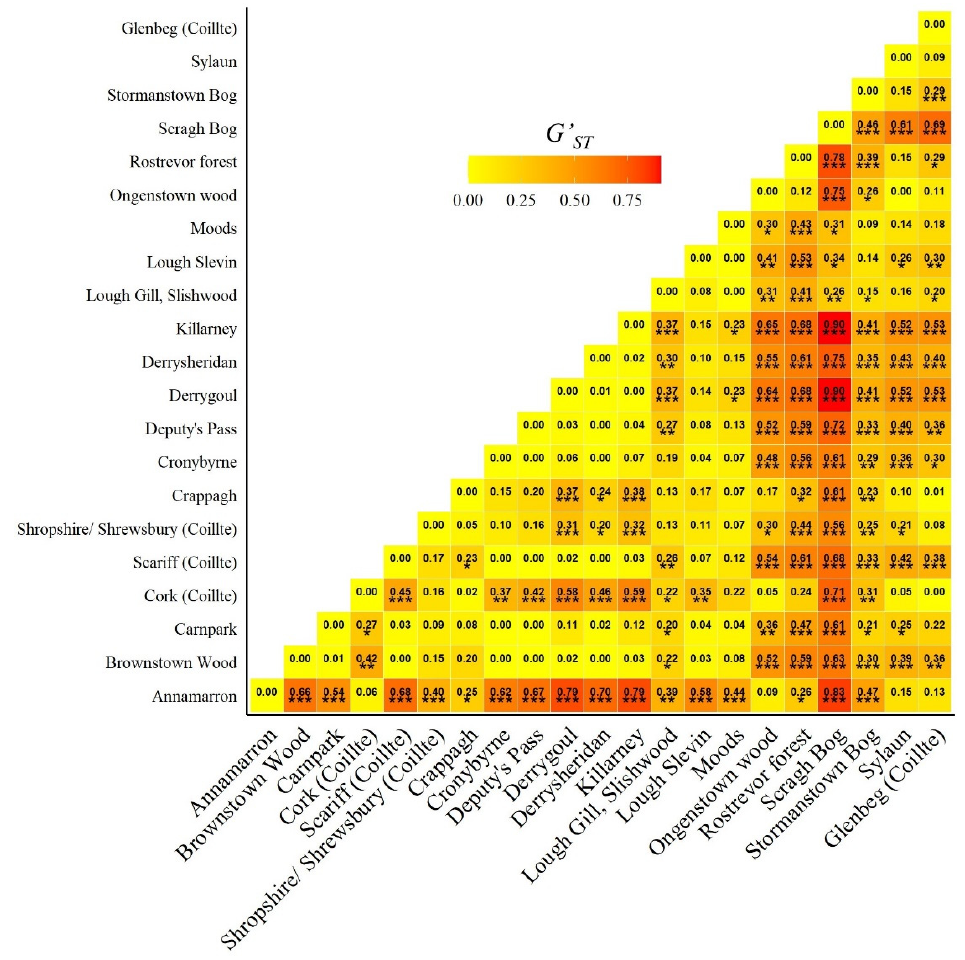
Figure 6. Pairwise G’ ST comparisons between sampling populations. Values which are significantly different from zero are marked with asterisks (* p ≤ 0.05, ** p ≤ 0.01, *** p ≤ 0.001), as determined from 1000 random permutations of the data. Table 4. Population differentiation statistics estimated across all haplotypes in the Irish, English, and Scottish sampling populations as well as separately across B. pubescens , B. pendula, and putative hybrids. Statistics include estimates of intra-population diversity ( h S ), total diversity ( h T ), diversity which apportions between populations ( G ST ), and G ST adjusted for the theoretical maximum based on mean heterozygosity ( G’ ST ). Bootstrapped 95% confidence intervals ( n = 1000 permutations) are provided in brackets. Bold values indicate statistical significance ( p ≤